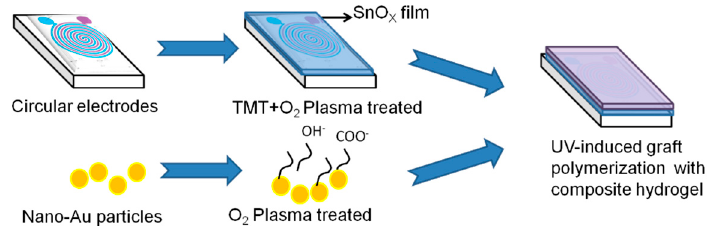
Figure 2. Flow chart in this study.